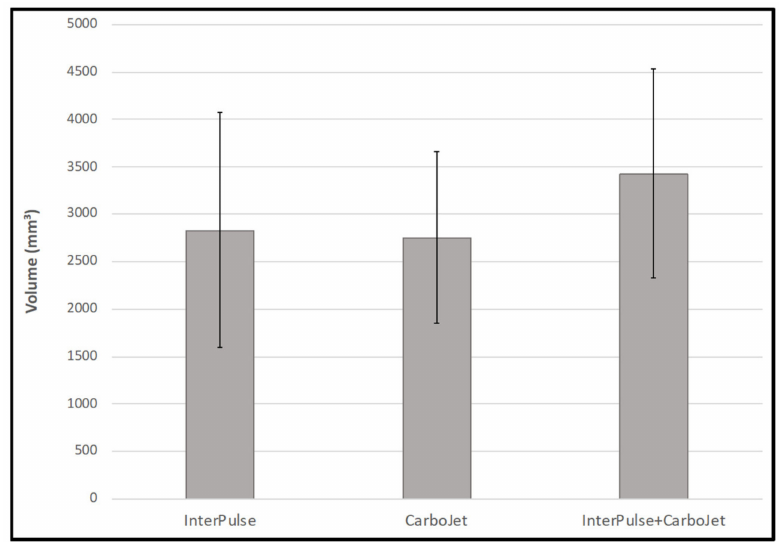
Figure 6. Volume of removed grease in standardized carbon foam specimens.